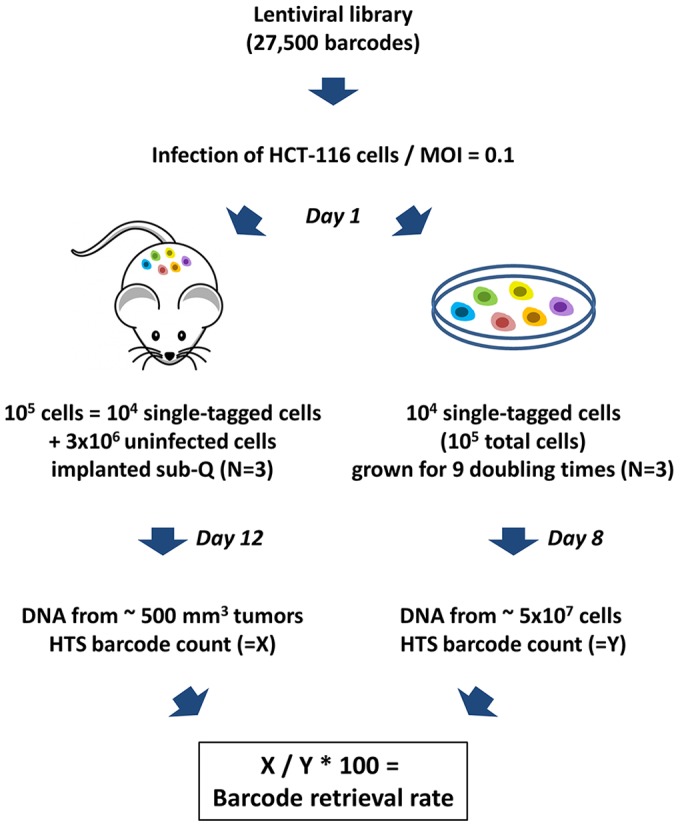
Tracing individually-labeled HCT-116 cancer cell clones in vitro and in vivo.
A lentiviral library containing 27,500 unique barcodes was used to transduce HCT-116 cells at an MOI of 0.1. Pools of 105 cells, corresponding to 104 individually tagged cells were either admixed with 3×106 cells and implanted subcutaneously into NSG mice or grown in culture in vitro. Cells were harvested after 9 days and tumor removed after 12 days, and total DNA preparations from cells or tumors were subjected to the barcode retrieval procedure.